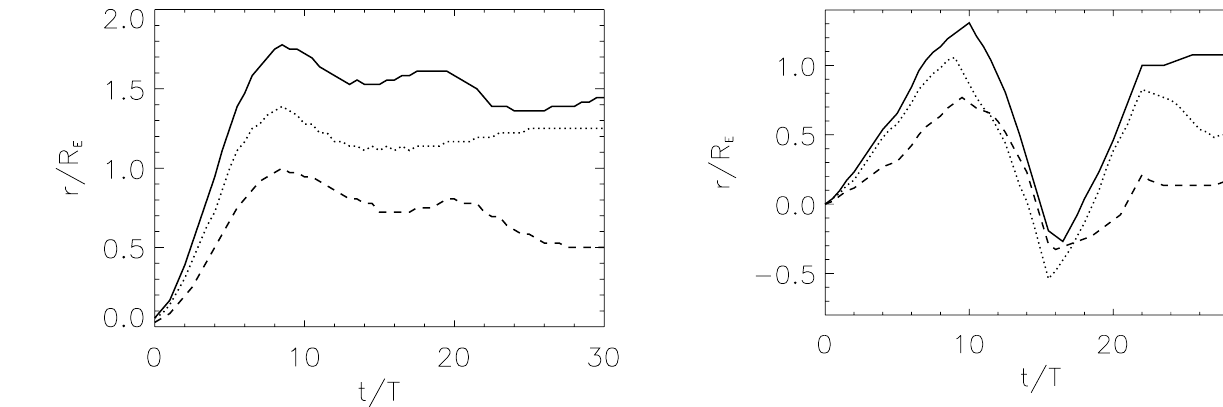
Fig. 9. Bow shock boundary oscillations, see Fig. 8 for definition of the position being considered. The normalizing time is here T ≡ R E /U where U is the solar wind velocity. We show results for 1n/n = 10% , 15% and 20%, keeping the solar wind velocity constant. See also Fig. 10.